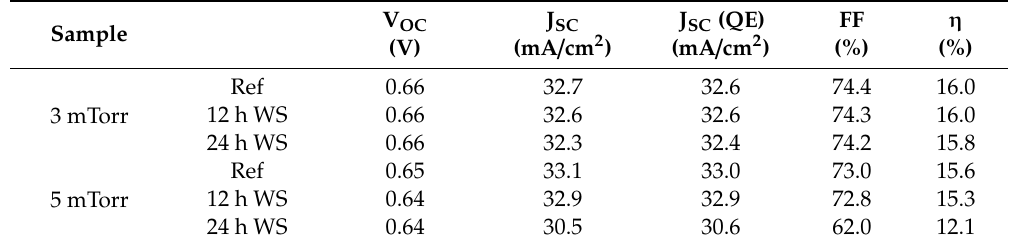
( a ) ( b ) Figure 7. Representative semi-log plots of the dark J-V curves for 3 mTorr samples ( a ) and 5 mTorr samples ( b ) for reference (black) and water-soaked (12 h: blue, 24 h: red) devices. Table 1. Solar cell parameters of representative cells shown in Figures 4 and 5.